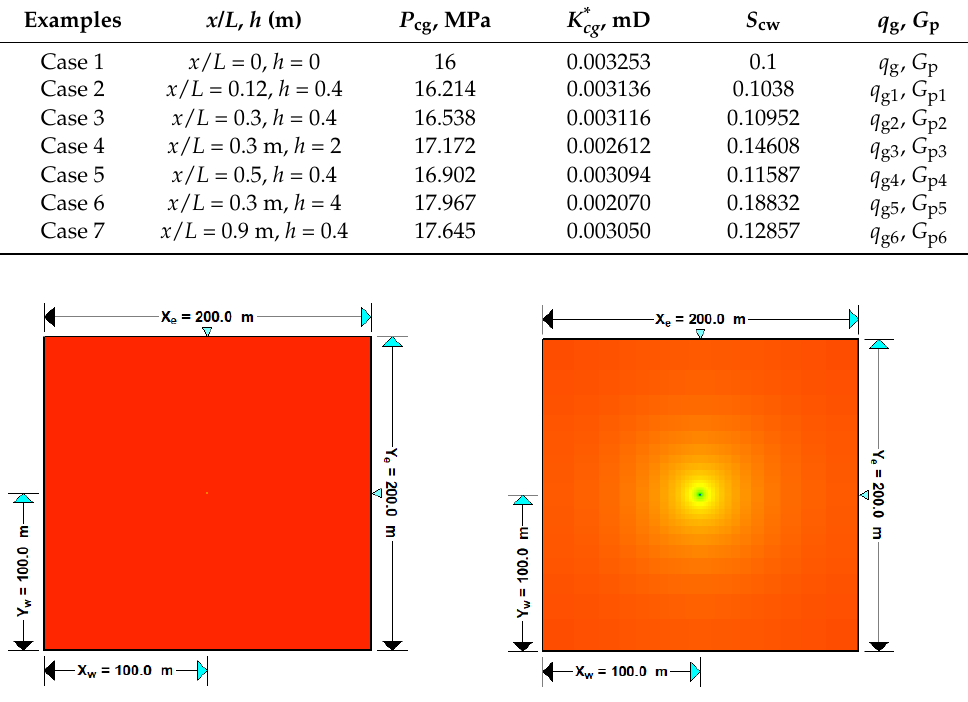
Figure 8. Model of wet coal—numerical vertical in harmony-CBM. (x-y) Pressure, iteration no. 9 to 347. Table 3. Maximum pore pressure immediately after drainage, matrix permeability, and water satu- ration within different imbibition degrees ( q g is daily gas production, G p is cumulative gas produc- tion).